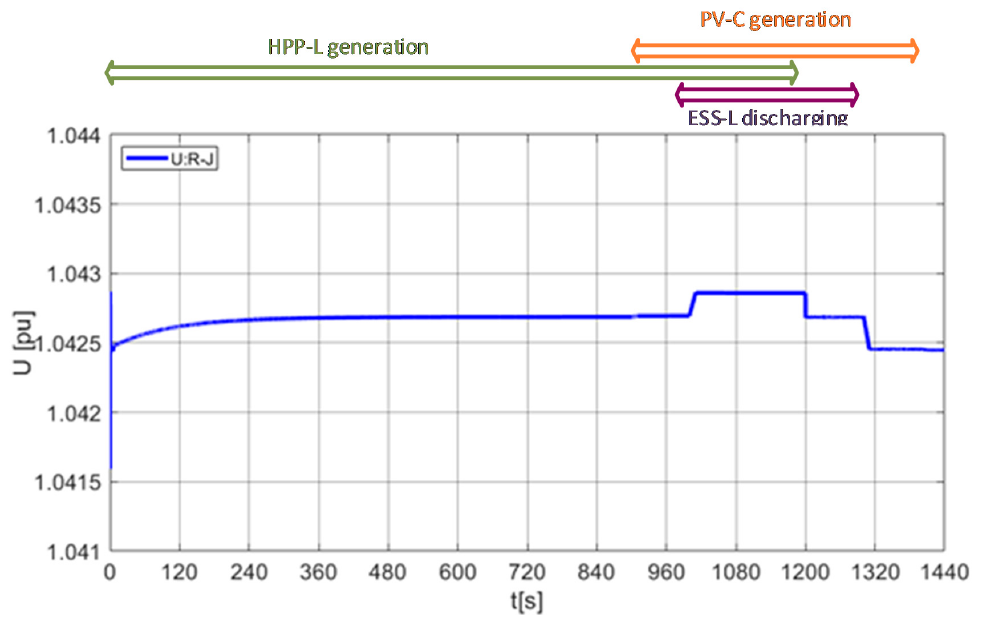
Figure 9. Voltage changes U at the secondary side of the HV / MV transformer in the main station R-J during the series of switching operations of HPP-L , PV- C and ESS-L